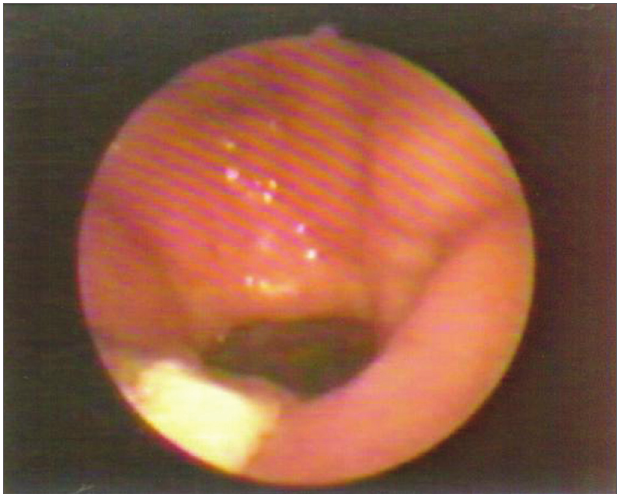
Figura 5. Paciente 3: fechamento do EVF em registro modal